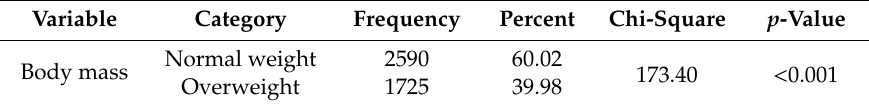
Table 2. Wrocław residents’ body mass following WHO criteria ( n =